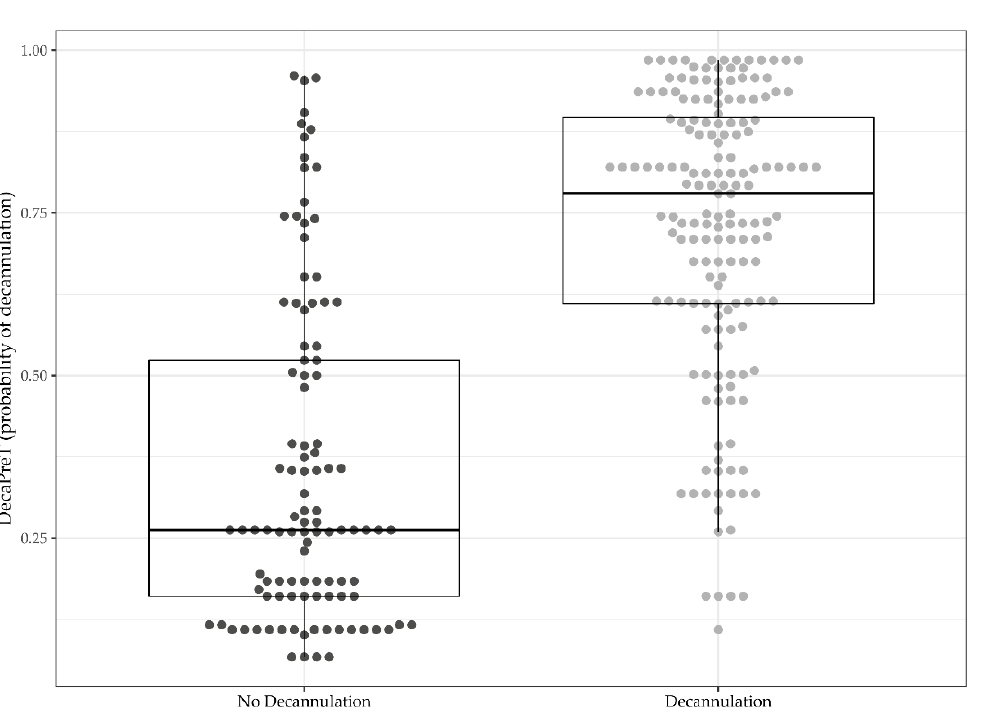
Table 2. Likelihood ratio test for Original, Calibration at large, Logistic calibration vs. the Revision models.